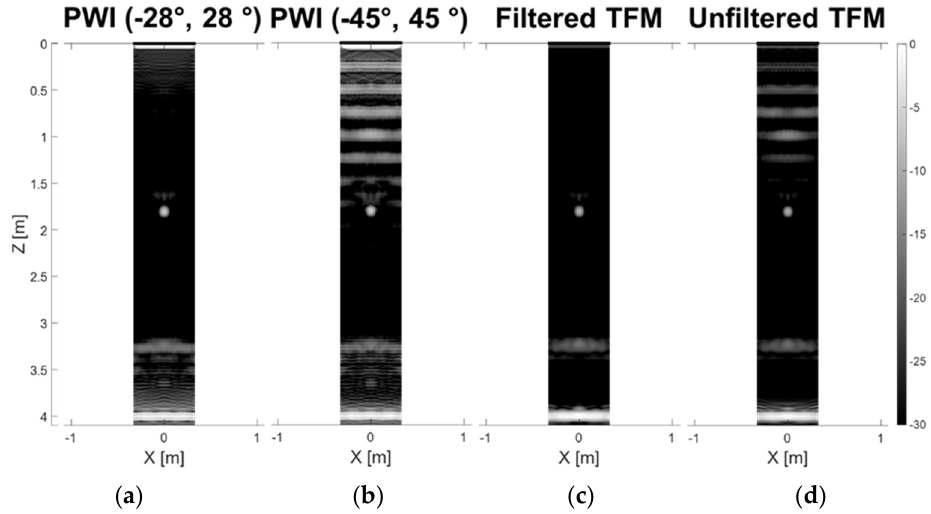
Figure A2. Comparison of reconstructions of FE pipe model with 1.3 λ SH0 , 75% through thickness deep crack at 1.8 m axial distance from the array. The unwrapped pipe images were reconstructed using PWI with the transmission angular range of ( a ) − 28° to 28°, ( b ) − 45° to 45°, and TFM using ( c ) FMC with waves travelling at angles larger than 28° removed, and ( d ) unfiltered FMC data. The image intensity is in decibel scale with respect to the cut-end reflection.